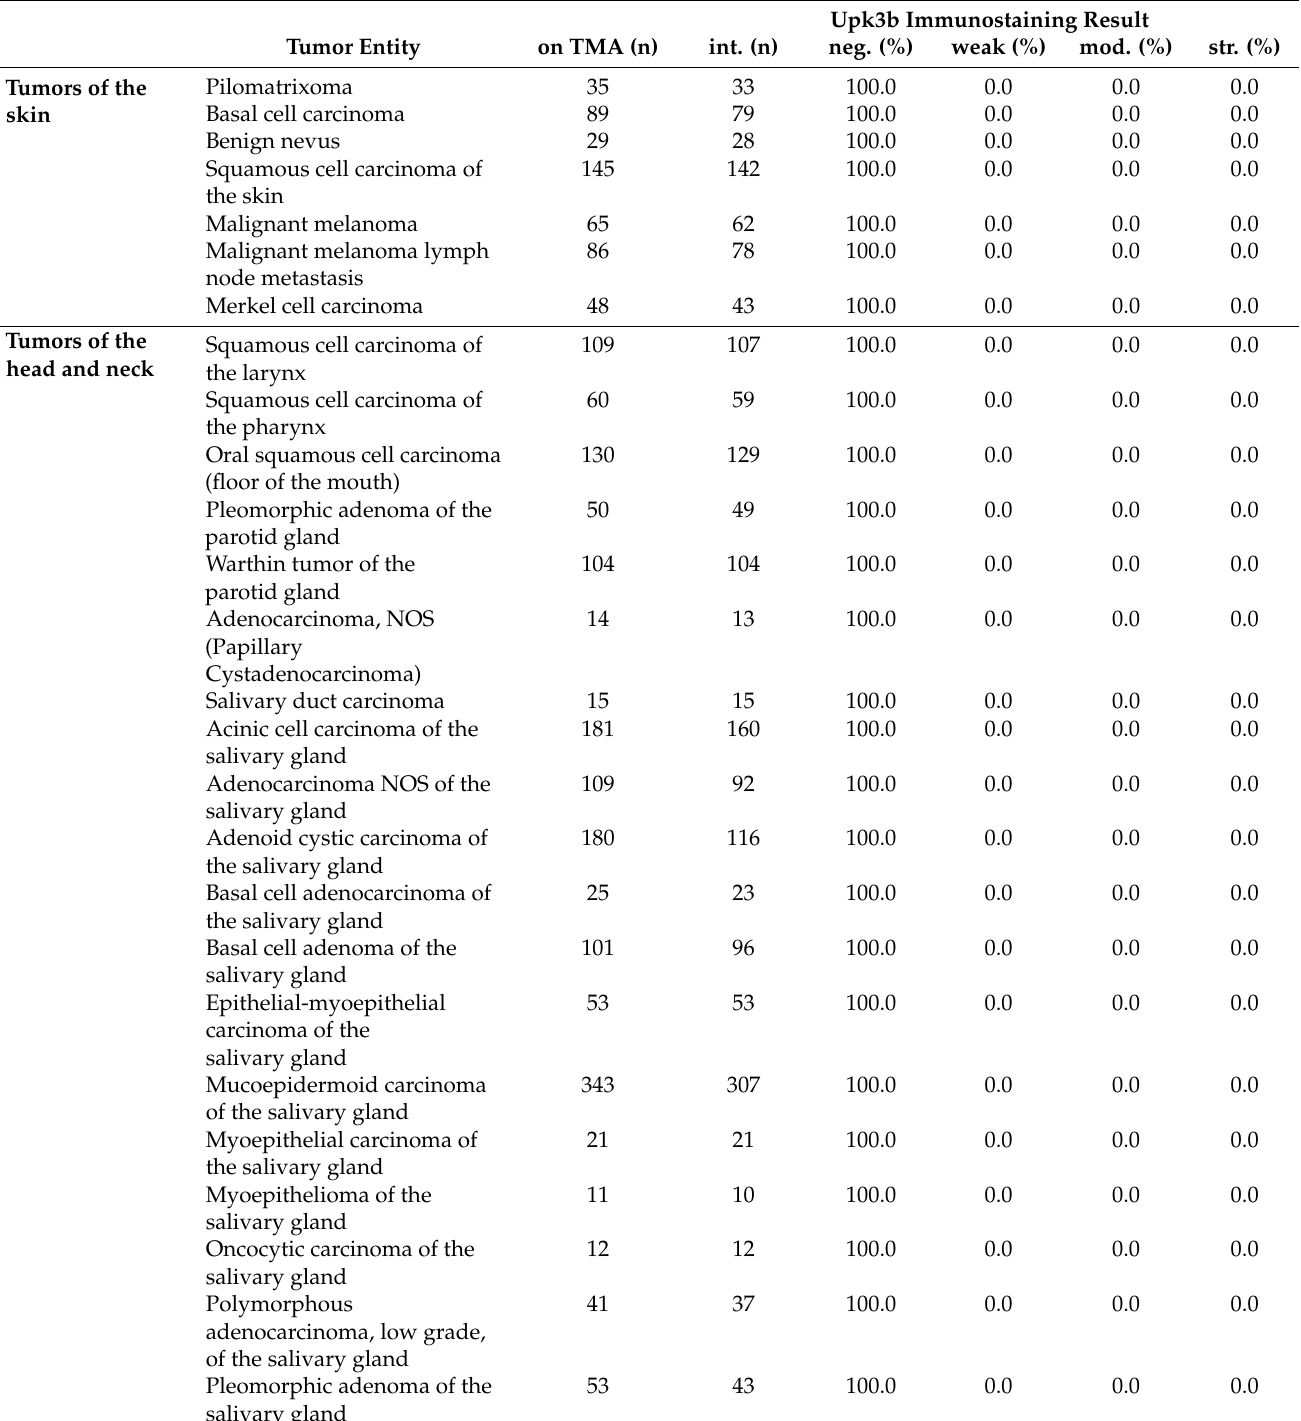
Table 1. Upk3 immunostaining in human tumors. int. = interpretable, neg. = negative, mod. = moderate, str. =